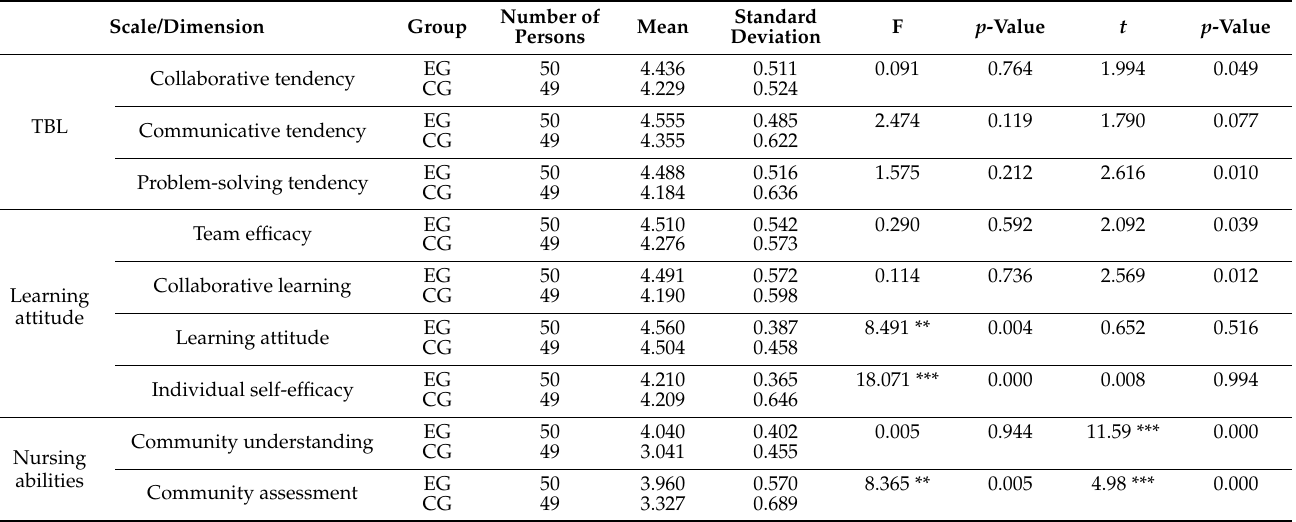
Table 2. Between-group differences in mean posttest scores for TBL outcomes, learning attitude, and nursing abilities ( N =